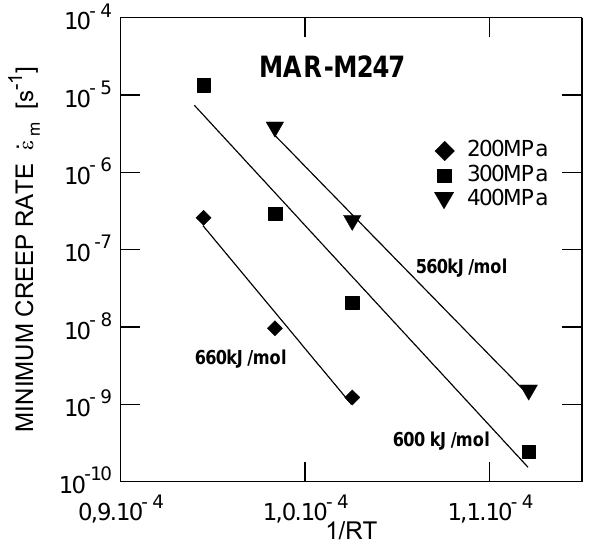
Figure 12: Determination of the activation energy of creep of the MAR-M247 alloy at different levels of applied stress.